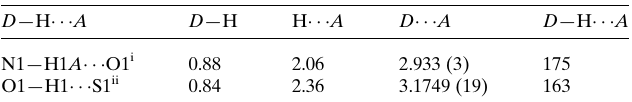
Table 1 Hydrogen-bond geometry (A˚ , (cid:2)